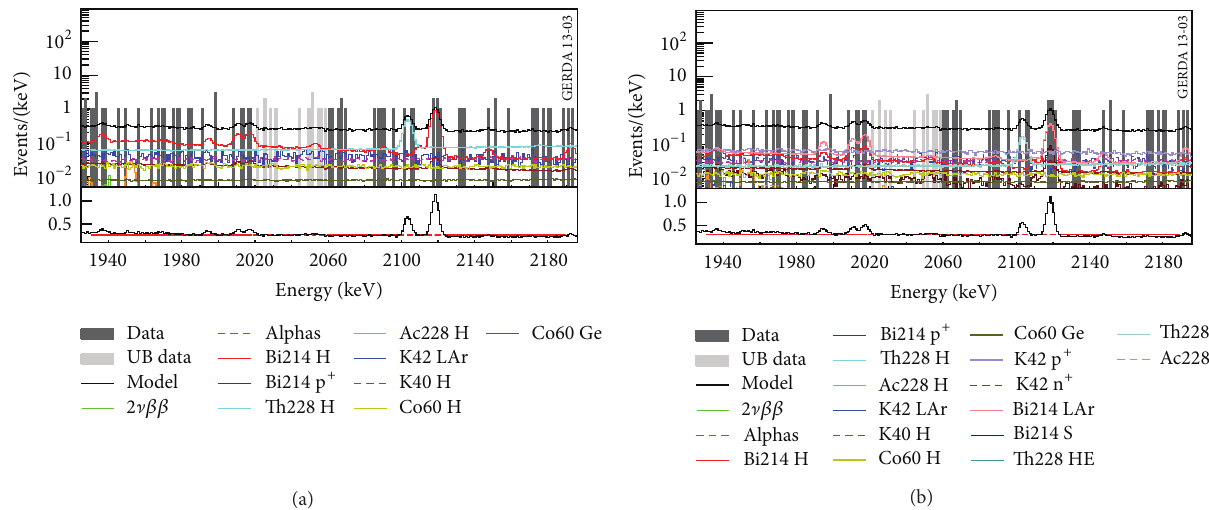
Figure 8: Experimental spectrum with minimum (a) model around 𝑄 𝛽𝛽 for the 𝐺𝑂𝐿𝐷 - 𝑐𝑜𝑎𝑥 data set. (a) shows the individual contributions of the considered background sources (colored curves) and the model prediction (black curve). The events colored in gray were used in the analysis, while the light gray shaded (unblinded data, UB data) ones have not been used in the analysis. The lower panel shows the best fit model fitted with a constant. In the fit, the peak areas predicted by the model and the 40keV blinding window are not considered. (b) shows the same experimental spectrum compared with maximum model around 𝑄 𝛽𝛽 for the 𝐺𝑂𝐿𝐷 - 𝑐𝑜𝑎𝑥 data set. From